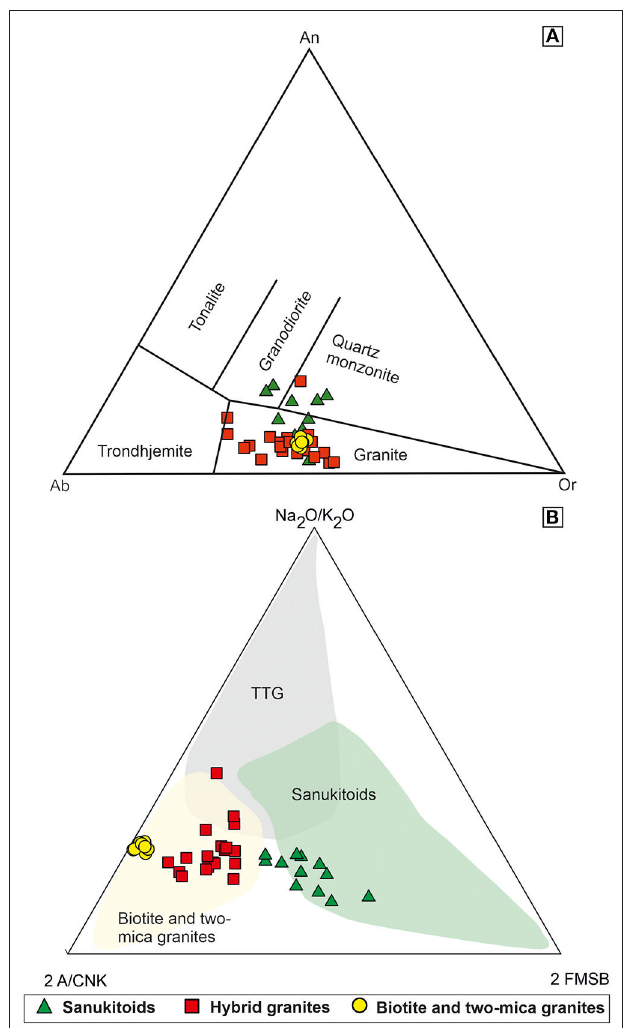
FIGURE 4 | (A) The distribution of Kanker granites on the normative An-Or-Ab triangle diagram (after O’Connor, 1965). (B) The disposition of the Kanker granites in the ternary classification diagram for Neoarchean granitoids (after Laurent et al., 2014), the fields correspond to that of well-studied suits from different